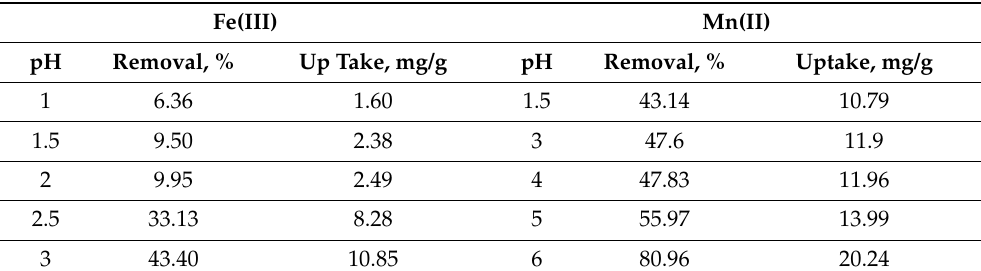
Figure 6. The influence of pH on the absorption and removal by AC(C-3) of Fe(III) and Mn(II) from aqueous solutions (conc. = 50 mg/L, time = 2 h, wt. = 0.05 gm, agitation velocity = 100 rpm and temp. 25 °C) by percentage.